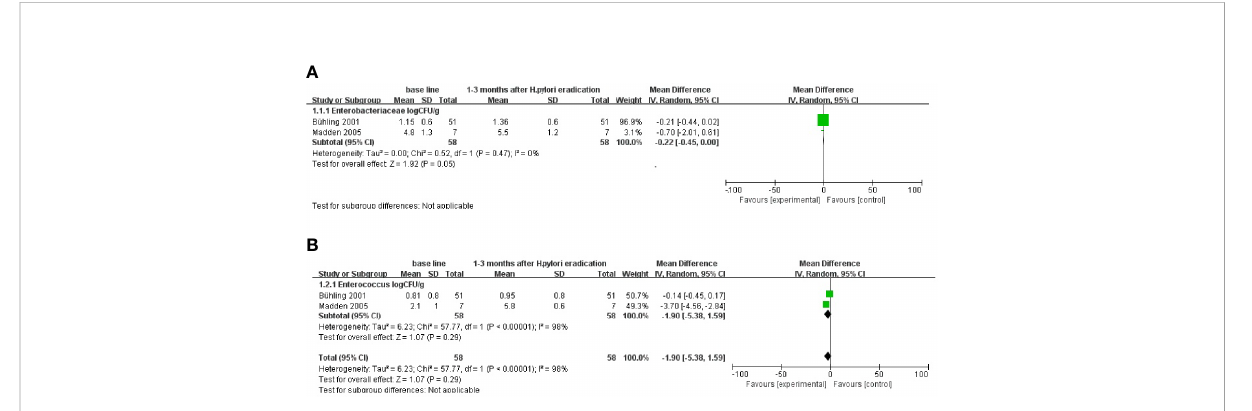
FIGURE 2 Follow-up results at the family and genus levels after Metronidazole-containing triple therap y of (H) pylori. (A) Changes in Enterobacteriaceae at 1 – 3 months after eradication treatment follow-up. (B) Changes in Enterococcus at 1 – 3 months after eradication treatment